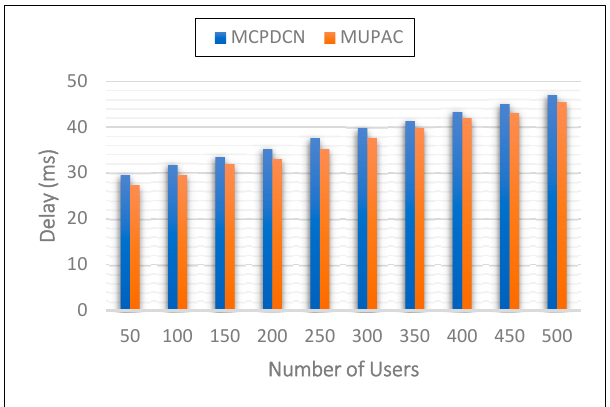
Figure 12. MUPAC vs. MCPDCN (delay) in terms of user density.